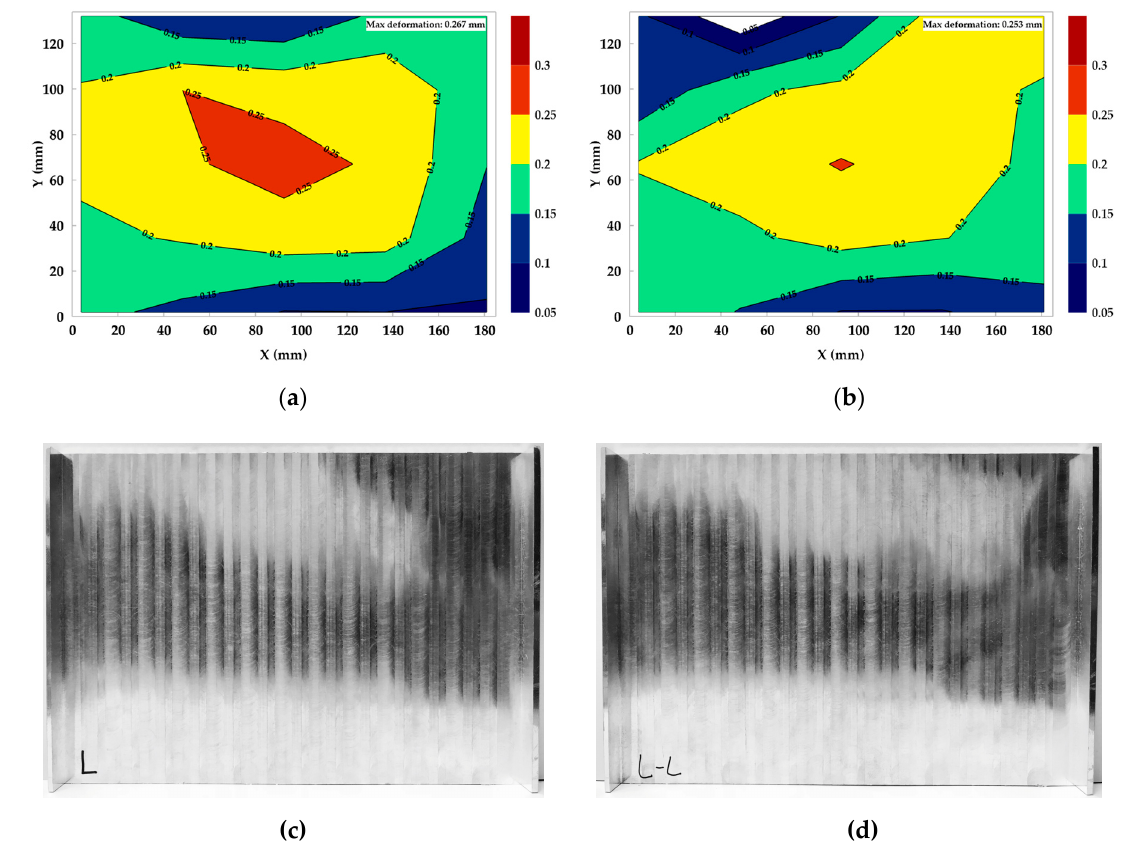
Figure 12. Deformation and surface roughness with the optimized experimental factor A1B1C1D4E4. ( a ) Max = 0.267 mm. ( b ) Max = 0.254 mm. ( c ) Ra = 0.261 μ m. ( d ) Ra = 0.291 μ m.